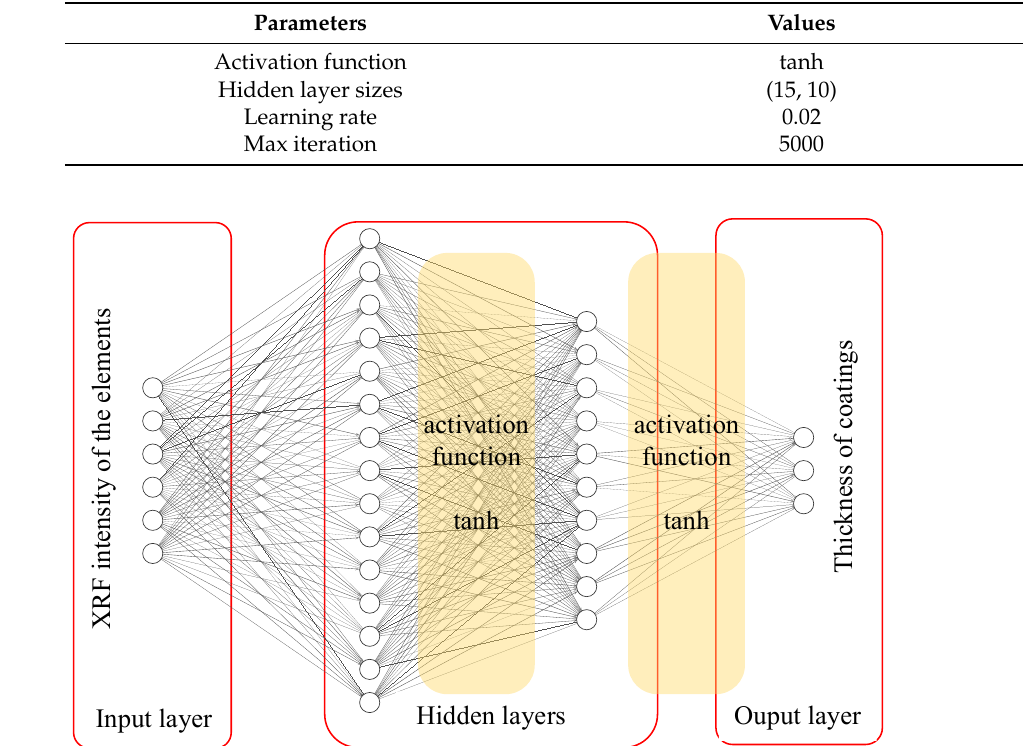
Figure 5. Topology of BPNN coating thickness prediction model.